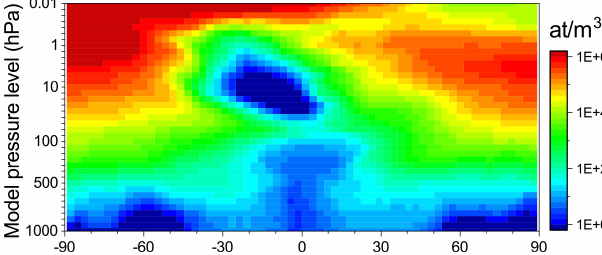
Figure 7. Distribution of the concentrations of 7 Be produced by the SPE on 20 January 2005 shown on 19 February 2005, 30d after the event.